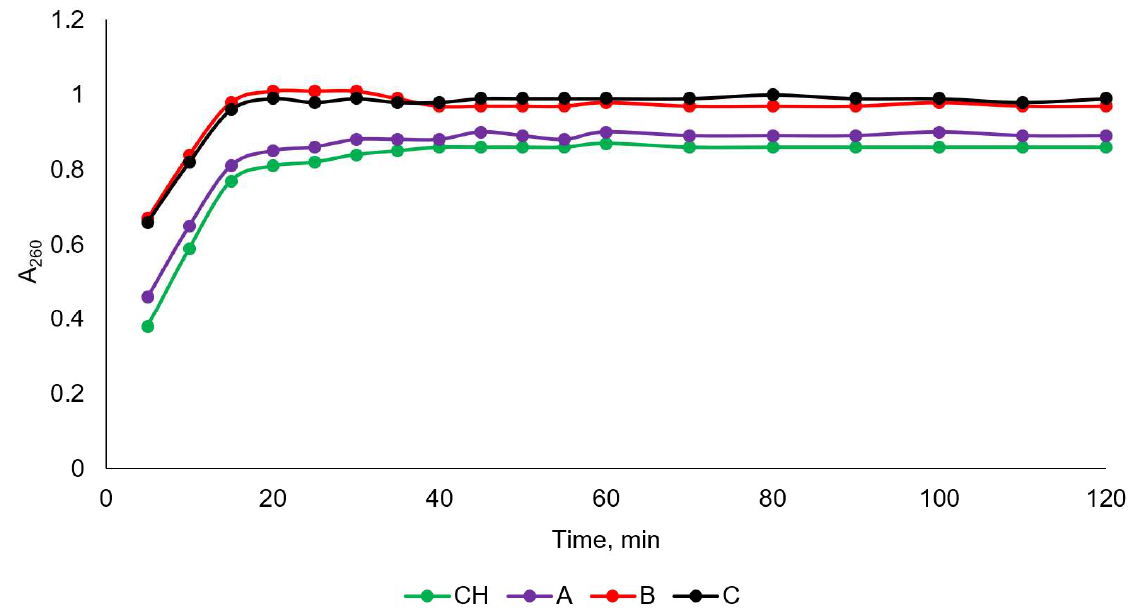
Figure 7. The effects of chitosan (CH), POX-1 (A), POX-2 (B), POX-3 (C) on the integrity of the cell membranes of S. aureus .